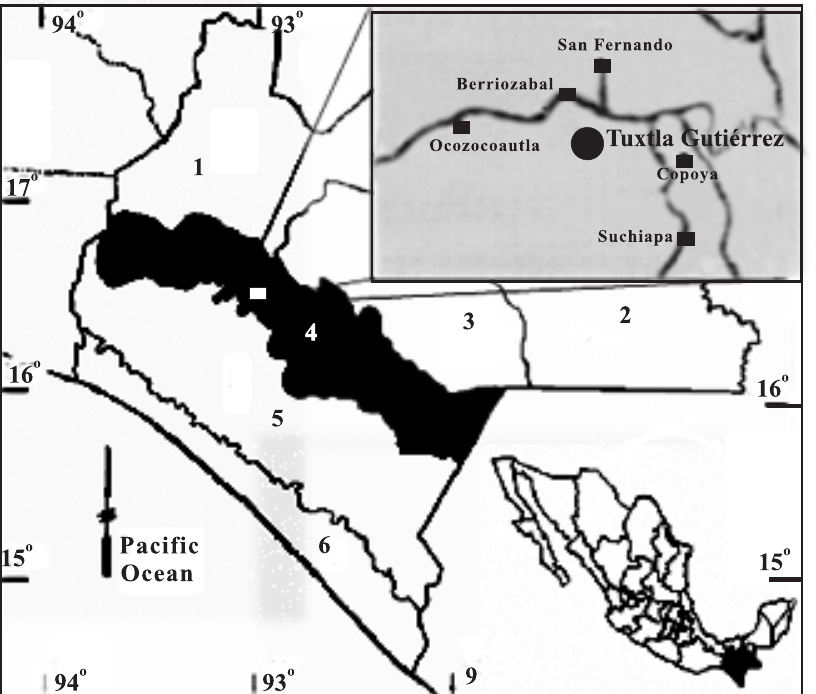
Figure 1. The six different eco-regions in Chiapas State, Mexico with (1) Northern Mountains (2) Eastern Mountains (3) Central High Plains (4) Central Depression (5) Sierra Madre de Chiapas (6) Pacific coastal plains. The small square shows the sampling area in